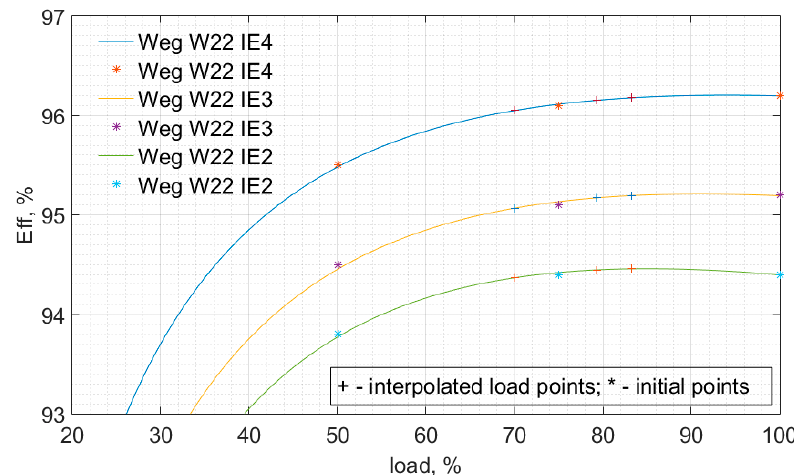
Figure 3. Motors’ efficiency interpolated curves and initial points. Figure 3. Motors’ e ffi ciency interpolated curves and initial points.